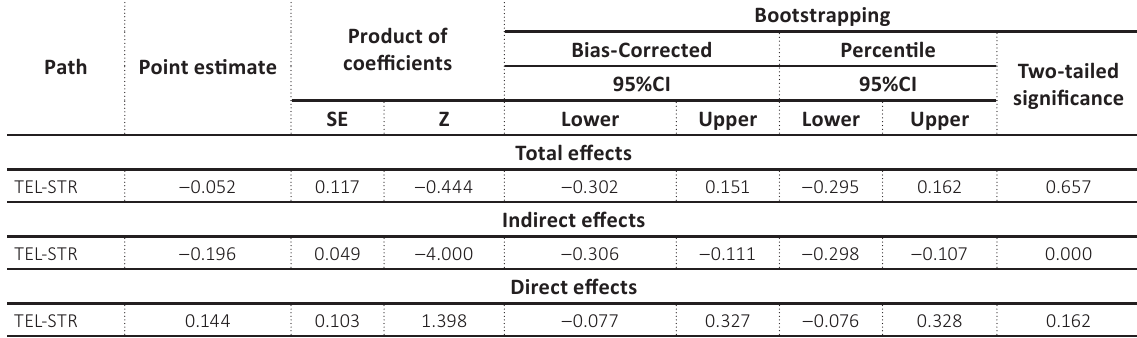
Table 9. Mediating effect